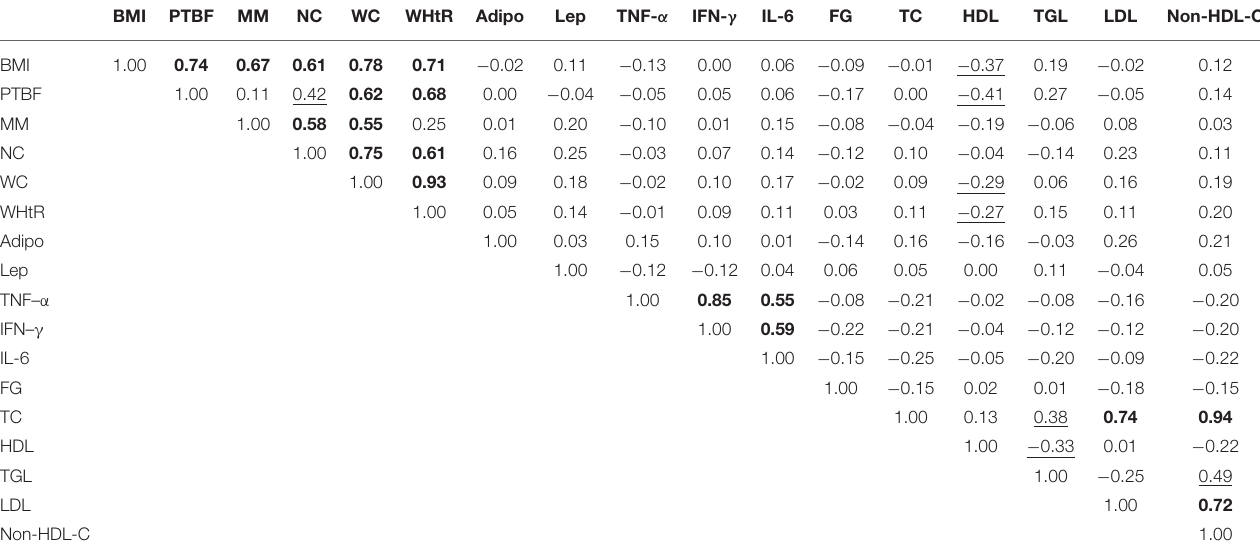
TABLE 11 | Simple Pearson’s correlation coefficients (r) among men for anthropometric parameters, body composition, adipocytokines, and